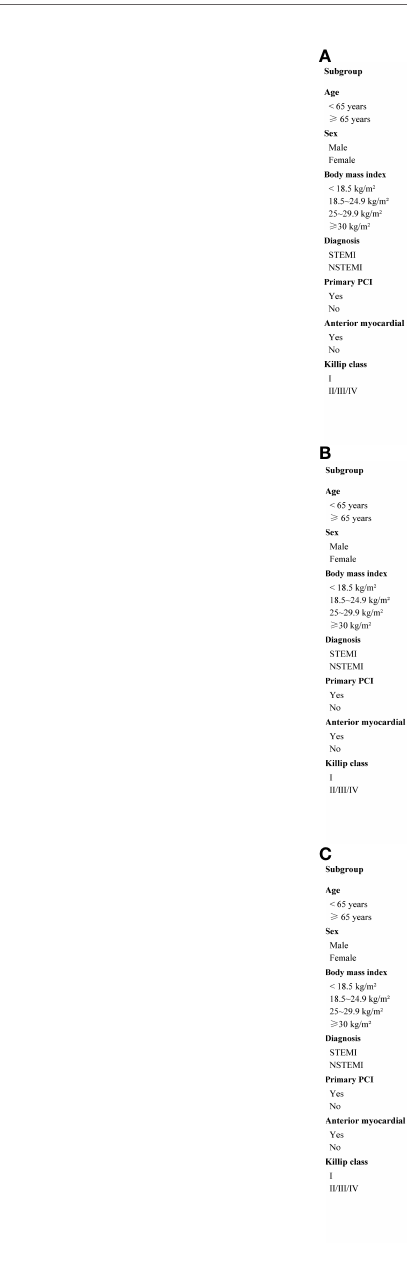
FIGURE 4 | Subgroup analysis for all-cause mortality in patients with different glucose metabolism status. (A) diabetes; (B) pre-diabetes; (C) normal glucose regulation. ABG, admission blood glucose; CI, con fi dence interval; NSTEMI, non-ST-segment elevation myocardial infarction; PCI, percutaneous coronary intervention; STEMI, ST-segment elevation myocardial